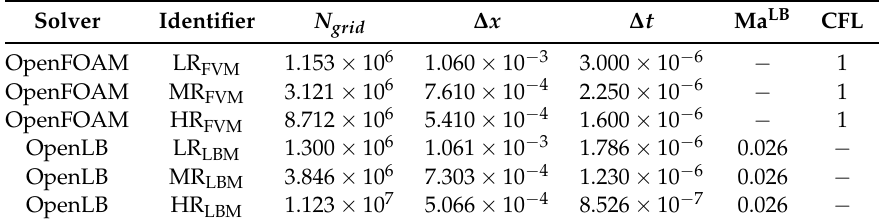
Figure 5. Slice representation of the Finite Volume and Lattice Boltzmann computational meshes. For OpenFOAM ( a ) an unstructured graded mesh and for OpenLB ( b ) a uniform Cartesian mesh is used. Table 2. Discretization parameters for the three grid configurations: low resolution (LR), medium resolution (MR) and high resolution (HR) for both OpenFOAM and